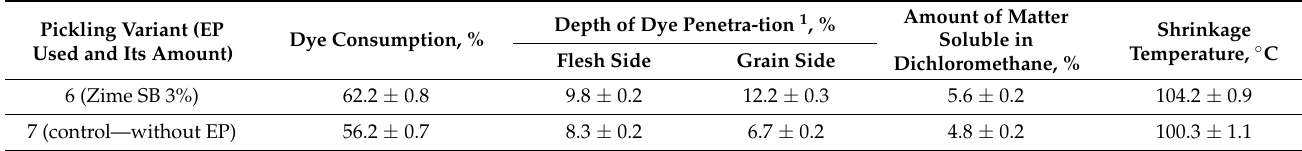
Figure 3. IR-spectra of hide. 1—pickled conventionally; 2—pickled adding EP Zime SB 3%. Table 3. Influence of pickling method on post-tanning processes and crust leather properties.